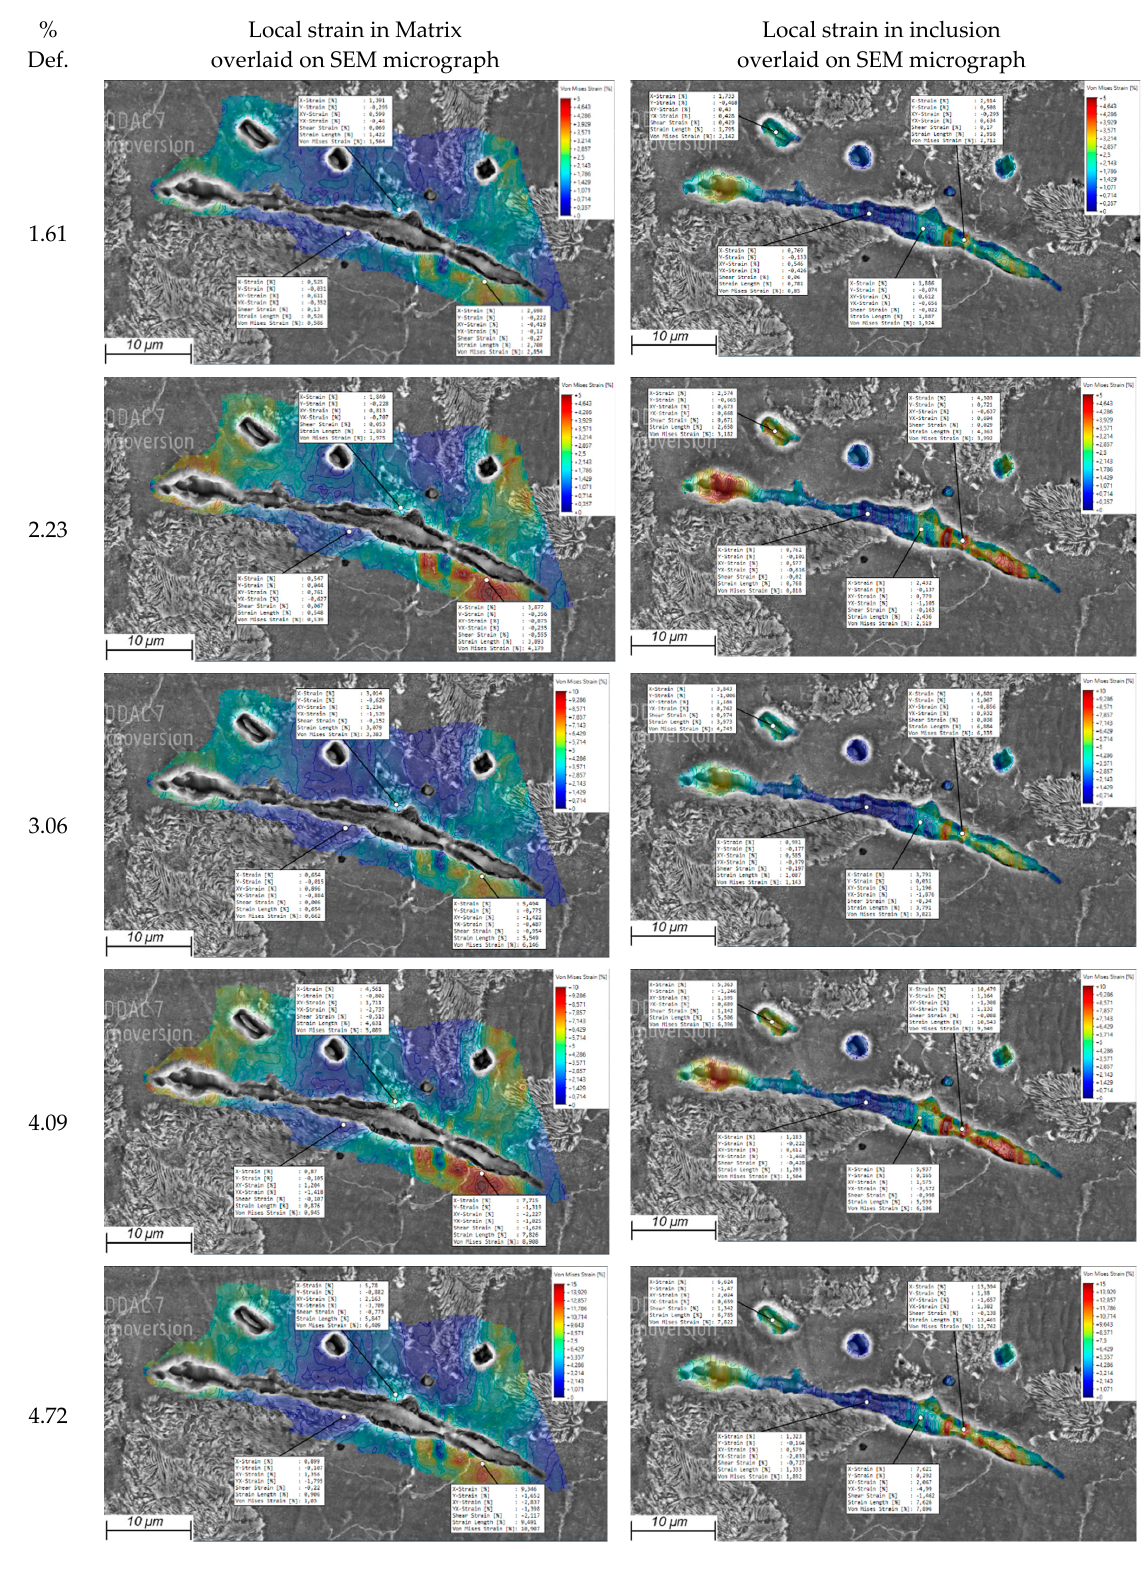
Figure A10. Cont